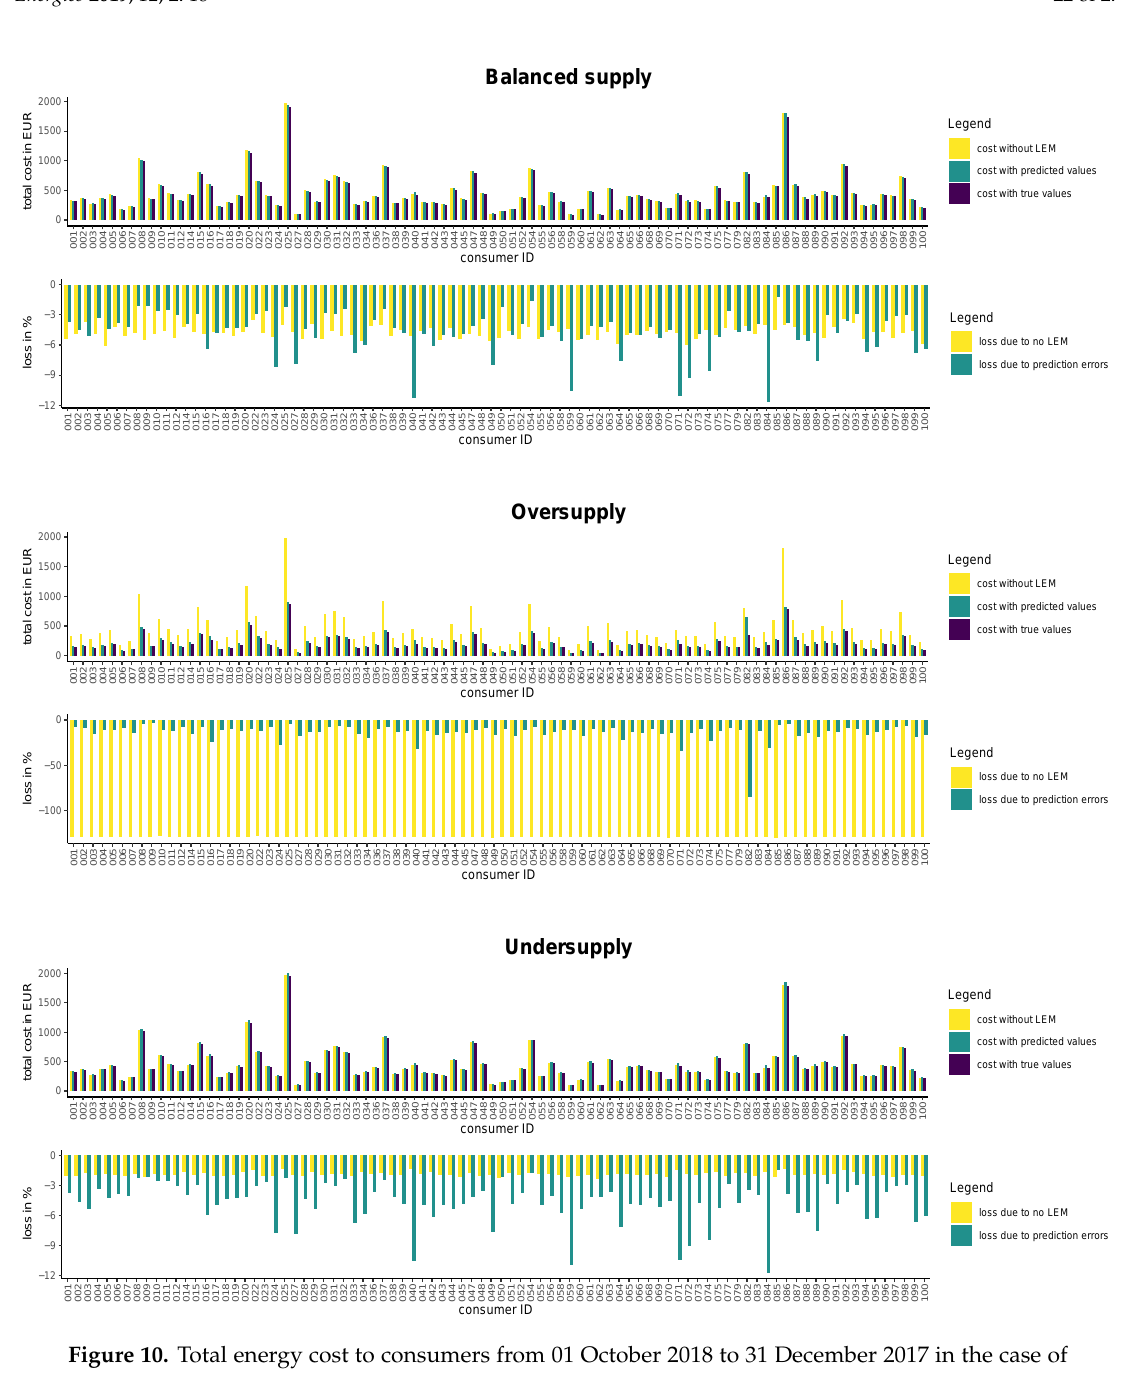
Figure 10. Total energy cost to consumers from 01 October 2018 to 31 December 2017 in the case of no LEM, LEM with true values, and LEM with predicted values in three different supply scenarios. BLEMevaluateMarketSim